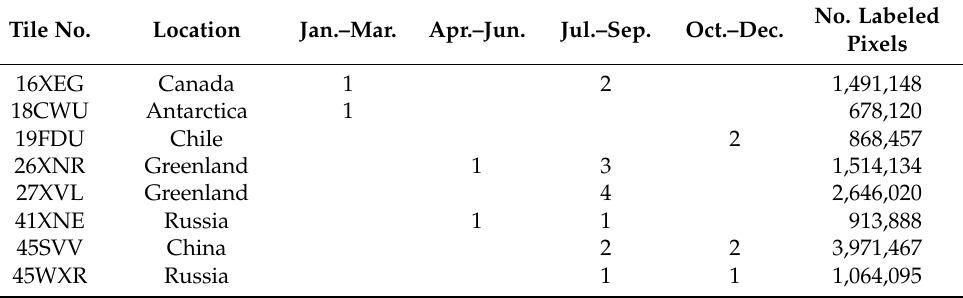
Table A2. Tile-wise quarterly distribution of scenes present in the validation